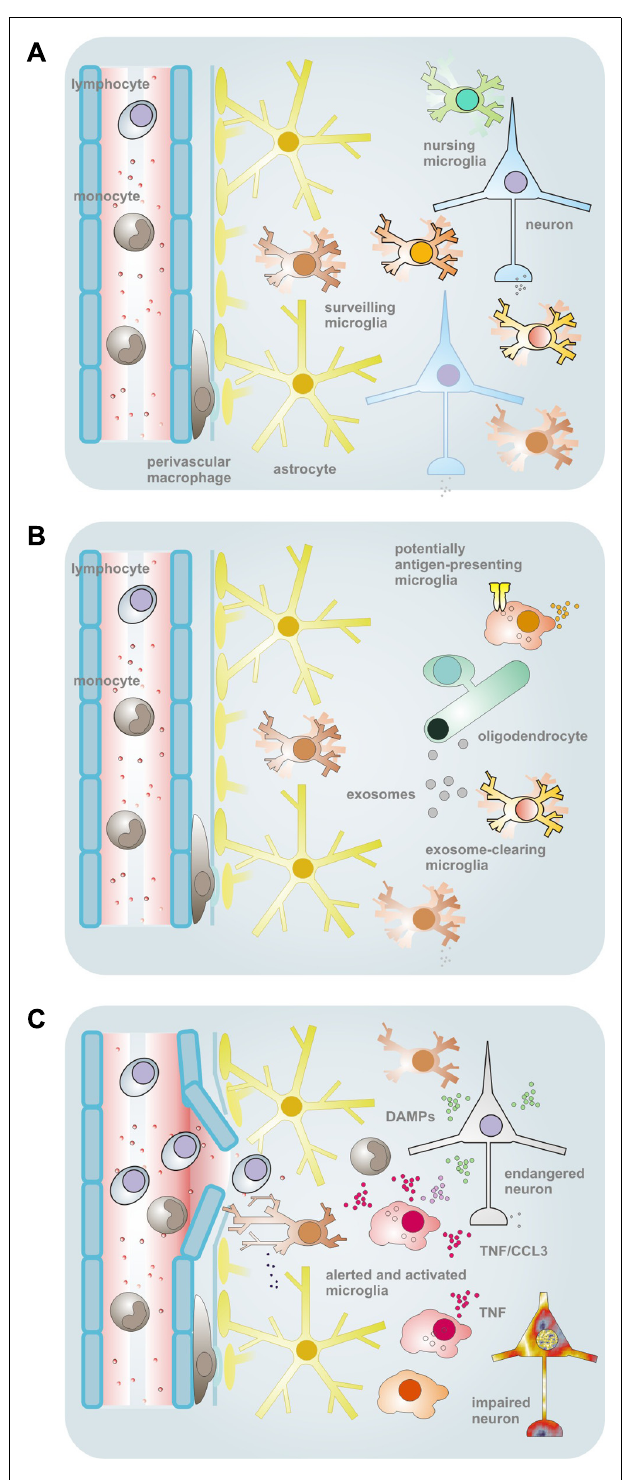
FIGURE 1 | Schematic overview of the conceptual framework and some supporting findings pointing to a heterogeneity of microglial properties. (A) In the normal CNS tissues, microglia comprise a population of myeloid cells with parenchymal distribution.The ramified morphology and a low expression of immune function-related molecules